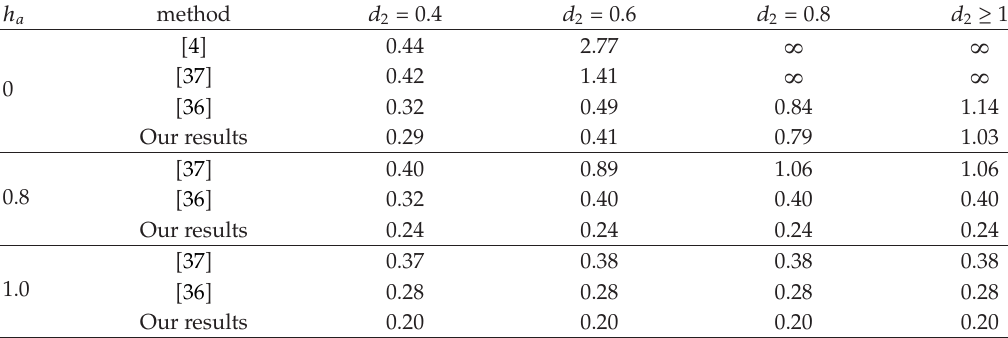
h b (cid:7) 1 . 25 (cid:4) . 1 unknown and